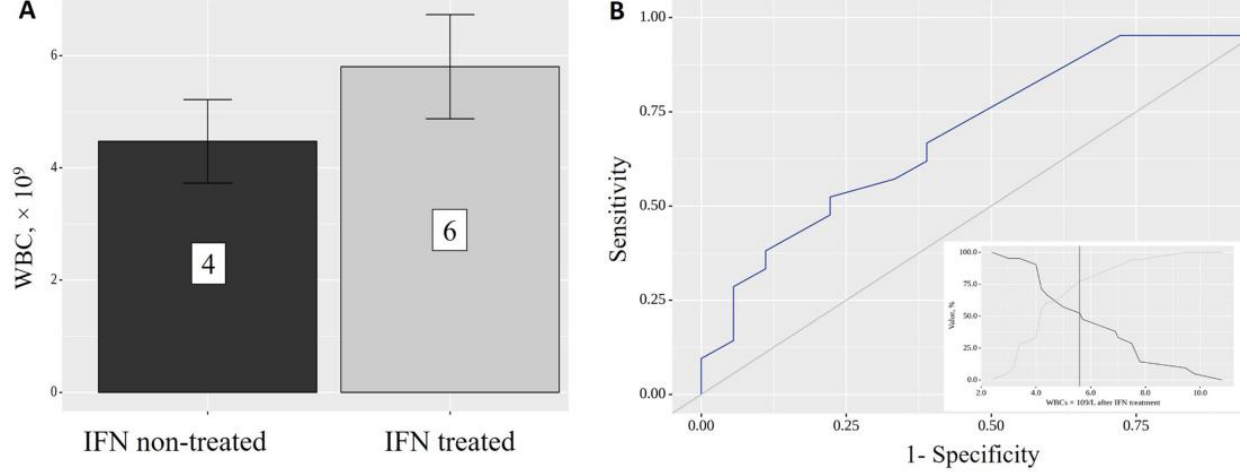
Figure 4. White blood cells (WBCs) following IFN- α 2b treatment ( A ); ROC curve of WBC elevation prediction following INF treatment ( B ).